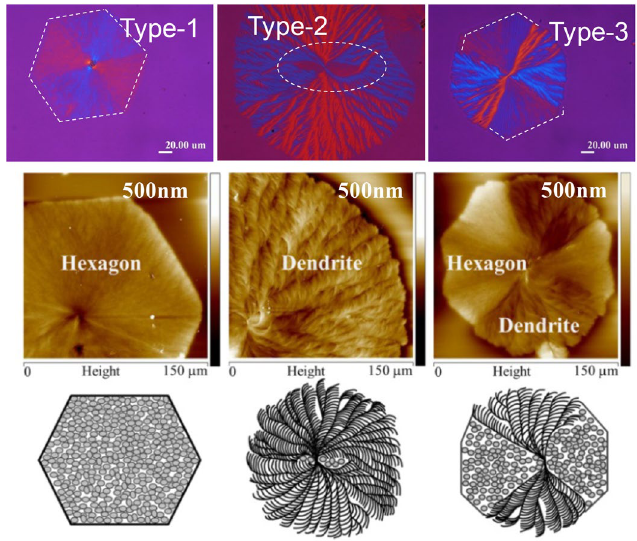
Figure 2. Simultaneous co-existence of multiple types of PLLA spherulites crystallized from PLLA/PVPh (70/30) blend at T c = 120 °C. Type-1: sole hexagon; Type-2: sole dendritic pattern; Type-3: Janus-face with hexagon/dendritic patterns combined in a same spherulite. Re-printed with permission from cited Ref. 19 .